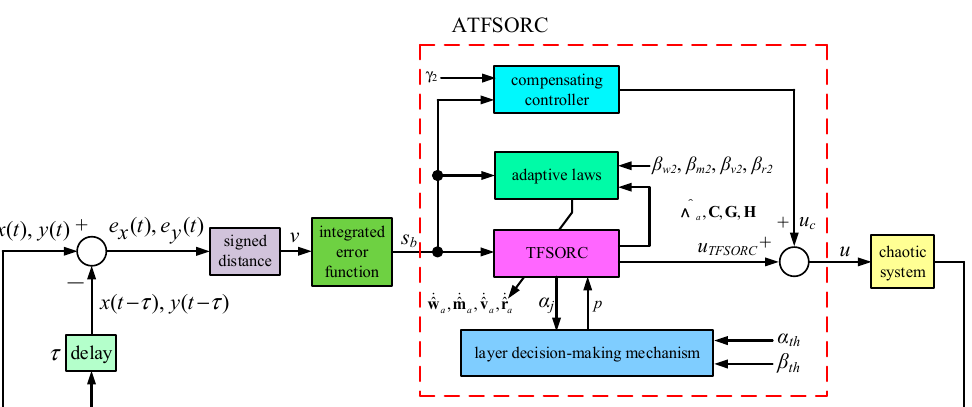
Figure 9. Architectural diagram of ATFSORC stability controller for chaotic system.